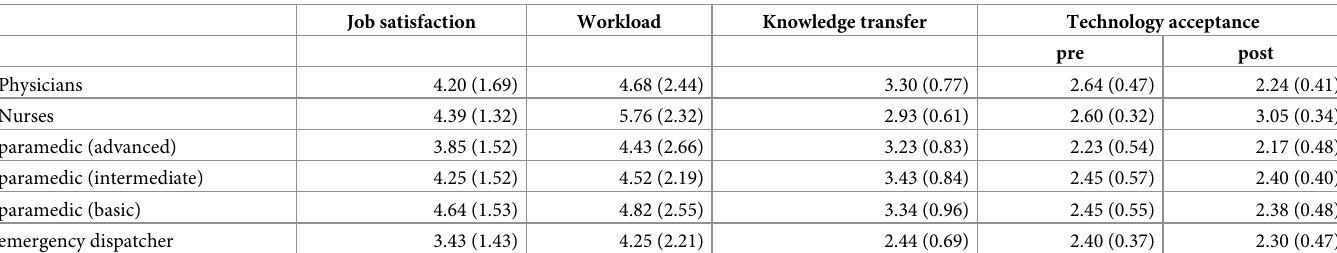
Table 4. Means (and standard deviations) of job satisfaction, workload, technology acceptance and active knowledge transfer as a function of professional